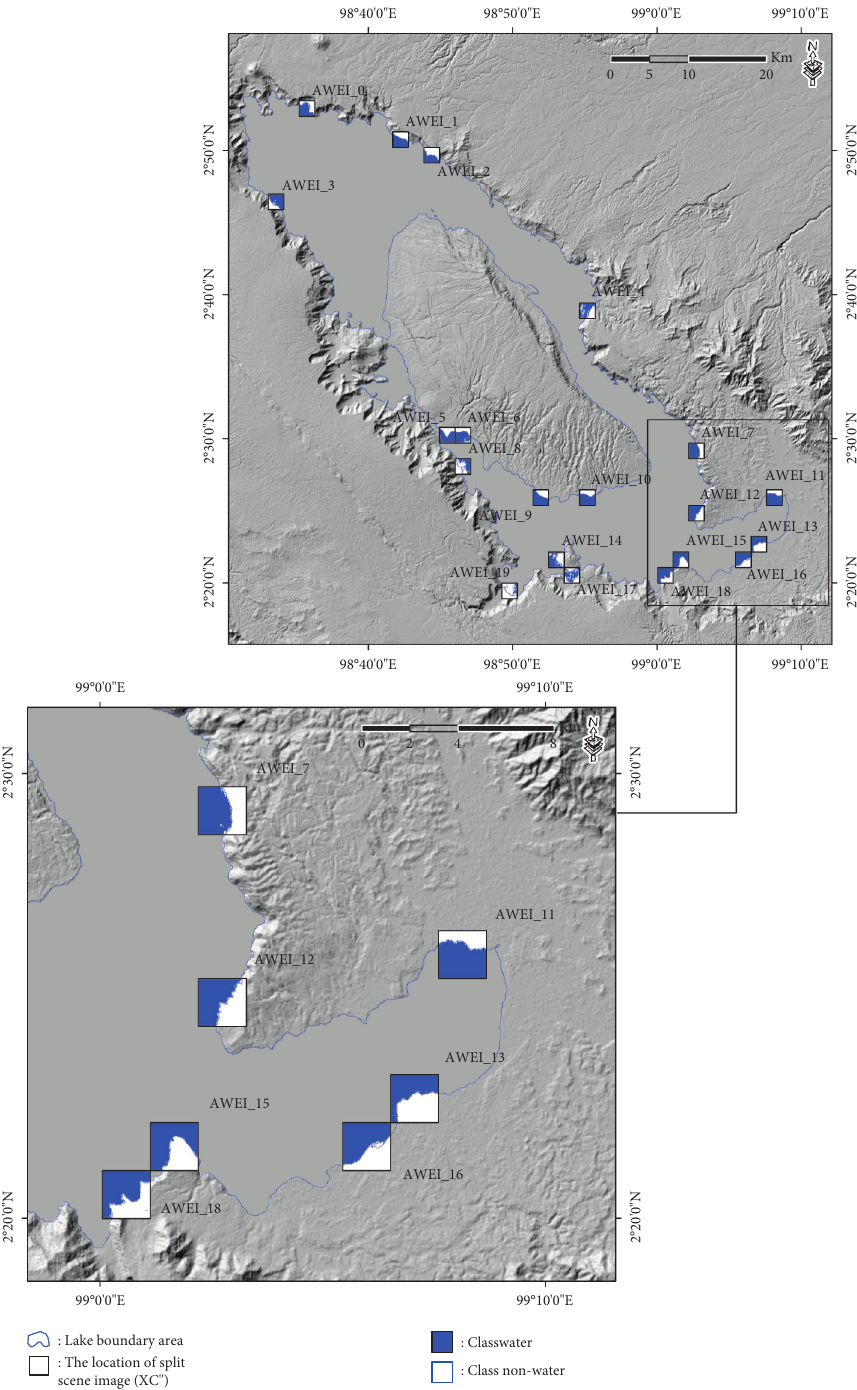
Figure 7: Location of the split scene image selection in the scene data ( XC ″ ) of the subscene images ( XCi ″ ) with a size of 2km × 2km based on the quantile threshold